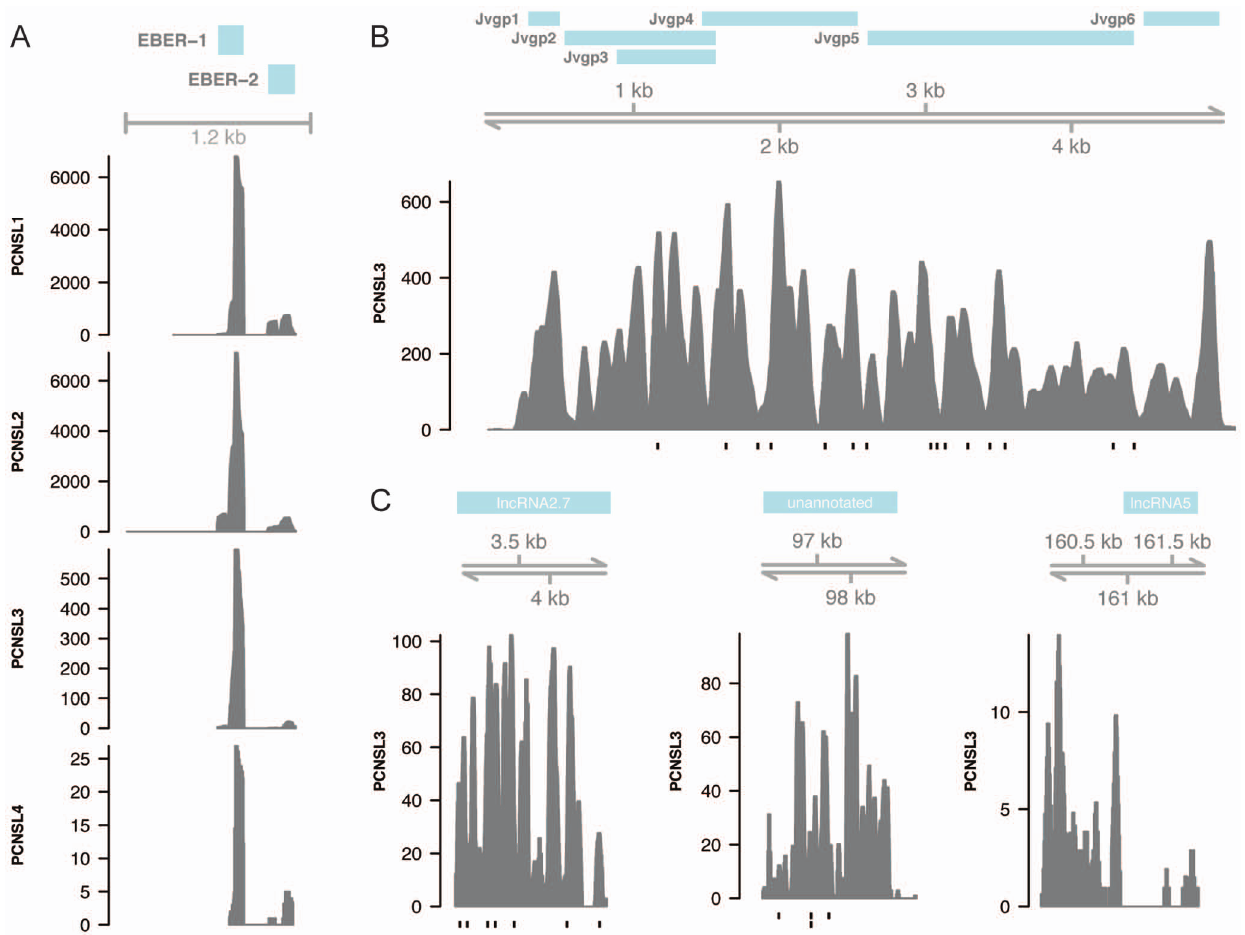
Figure 1. Viral read coverage. A. Read coverage (number of reads) across EBV latent genes EBER-1 and EBER-2 in four PCNSL samples. B. Read coverage across the entire JCV genome in PCNSL3. C. Read coverage across three cytomegalovirus ncRNA in PCNSL3. All alignments produced using BWA (25 bp seed, default options otherwise). Vertical black lines below histograms indicate variants relative to the reference sequence.